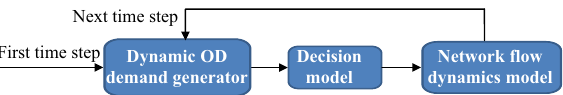
Fig. 4 Simulation process flow in each time step